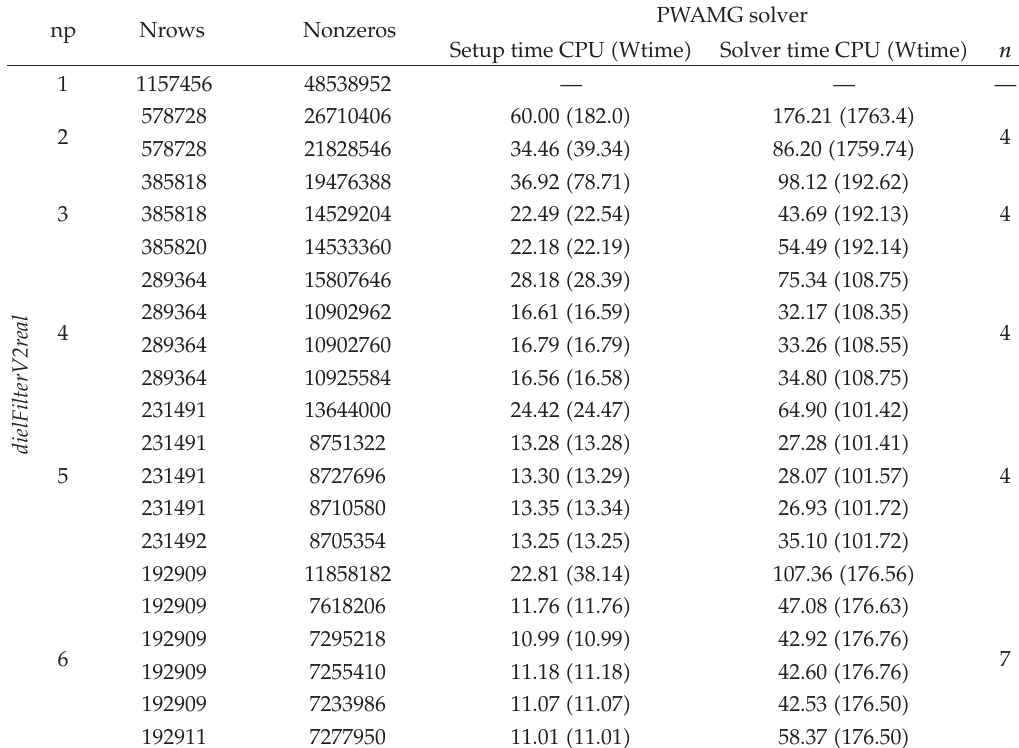
Table 6: Parallel results for dielFilterV2real matrix (cid:2) not enough memory (cid:3) .